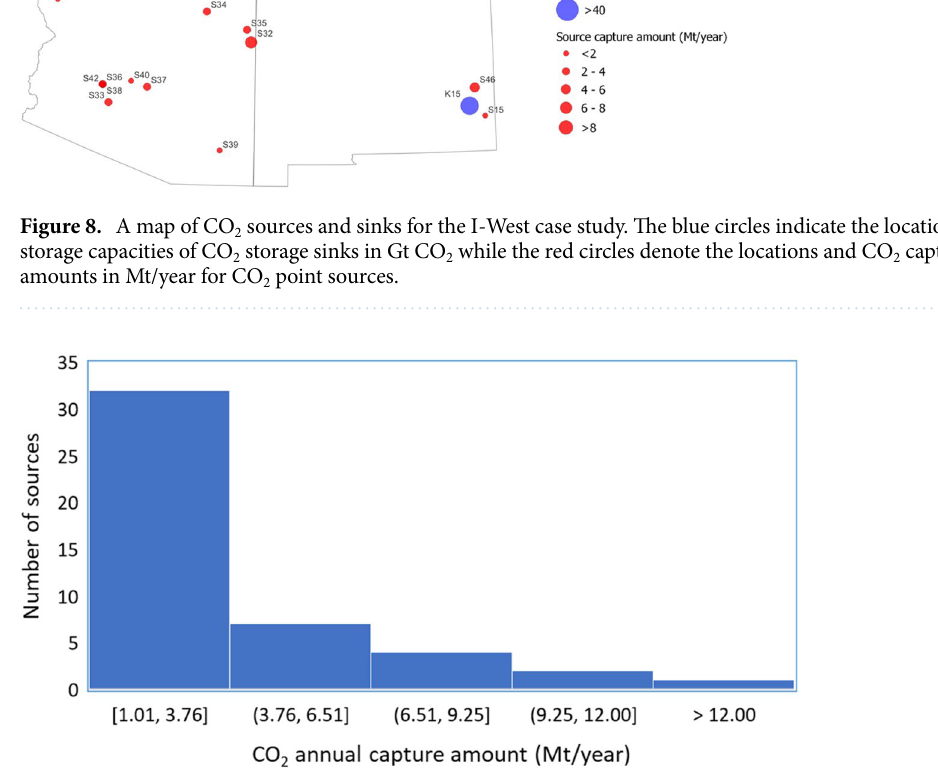
Figure 9. Distribution of annual CO 2 capture amounts for 44 sources for the I-West case